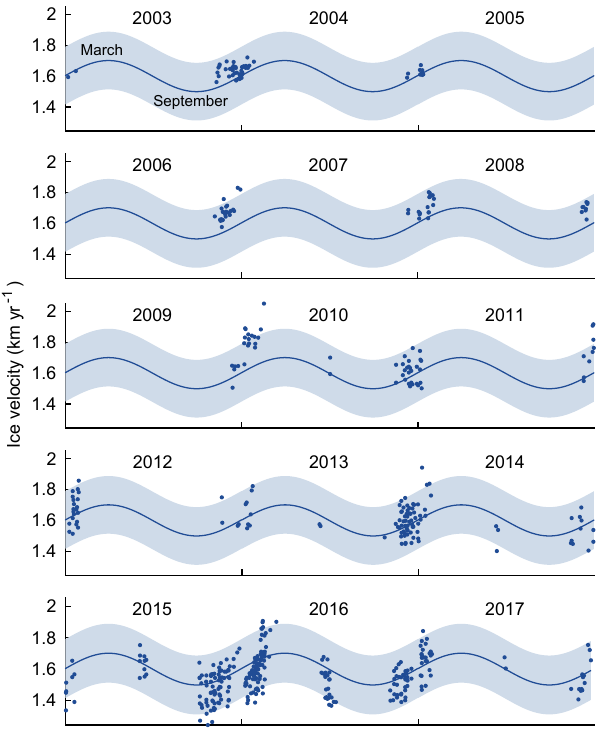
Figure 3. Seasonal cycle of ice shelf velocity from MODIS. TIS velocity measurements from 565 MODIS image pairs separated by 92 to 182 days, averaged within the pink polygon shown in Fig. 1. Velocity measurements are shown at the mean of the acquisition times of their MODIS image pairs. The average seasonal cycle is shown approximated as a sinusoid, with 95% confidence intervals